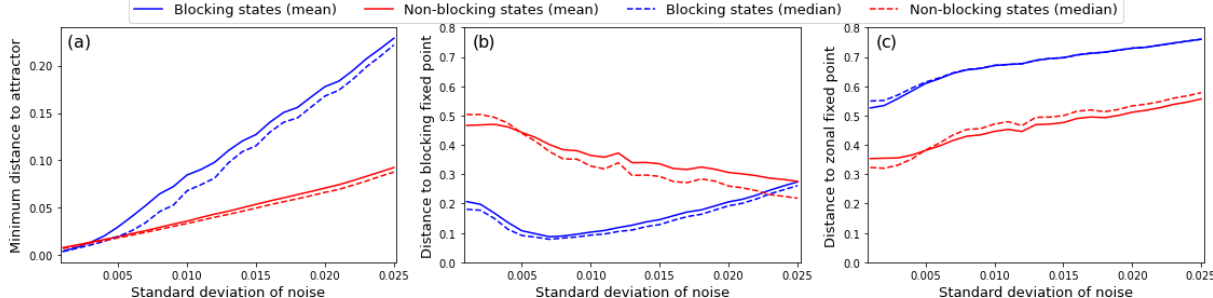
Figure 7. (a) The mean (solid lines) and median (dashed lines) Euclidean distance between points in the stochastic simulation and their closest neighbour on the deterministic attractor, shown for the blocking and non-blocking regimes. (b, c) As in (a) but showing the distance between points in each simulation and the blocking (b) and zonal (c) equilibria respectively.